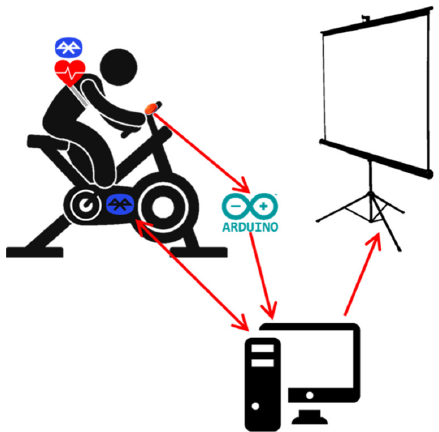
Figure. 2. The system configuration. In this case, the user is wearing a chest band equipped with a sensor and a Bluetooth module for the communication with the cycle ergometer controller. a sensor and a Bluetooth module for the communication with the cycle ergometer